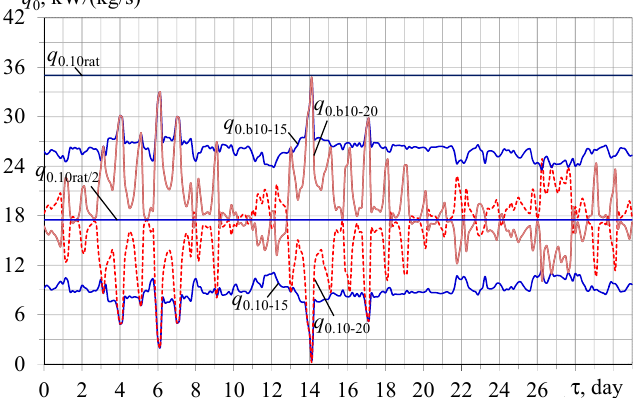
Figure 5. Actual values of refrigeration capacities q 0.10-15,20 for further conditioning of air from 15 ° С and 20 ° С to 10 ° С and residual booster values q 0.b10-15,20 for preconditioning ambient air to 15 ° С and 20 ° С : q 0.10-15,20 = q 0.10 − q 0.15,20 , q 0.b10-15,20 = q 0.10rat − q 0.10-15,20 .